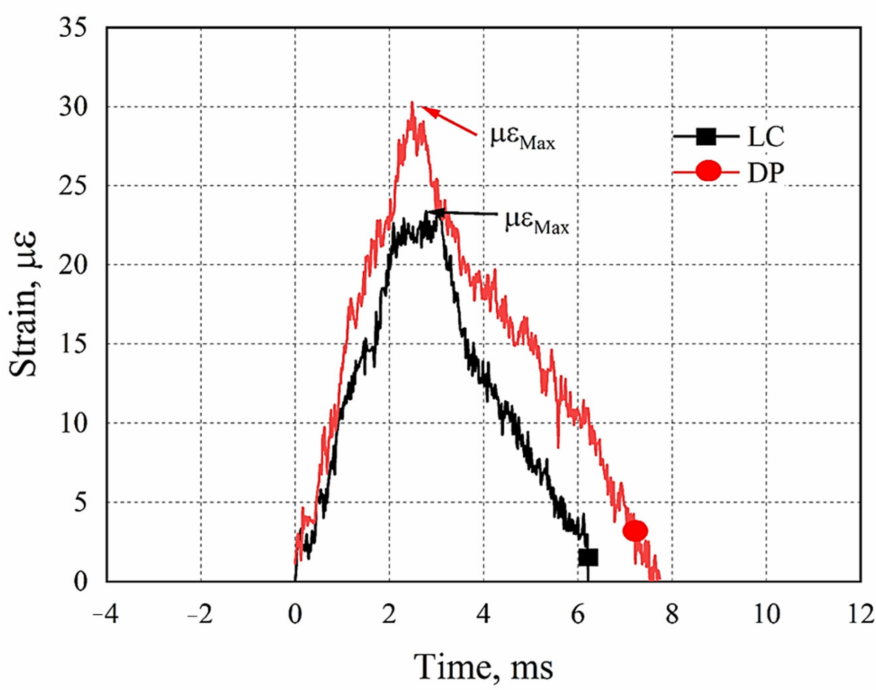
Figure 8. Strain–time behavior of LC and DP